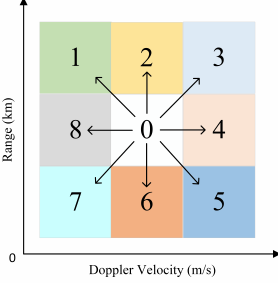
Figure 2. Schematic diagram of multi-directional gradient